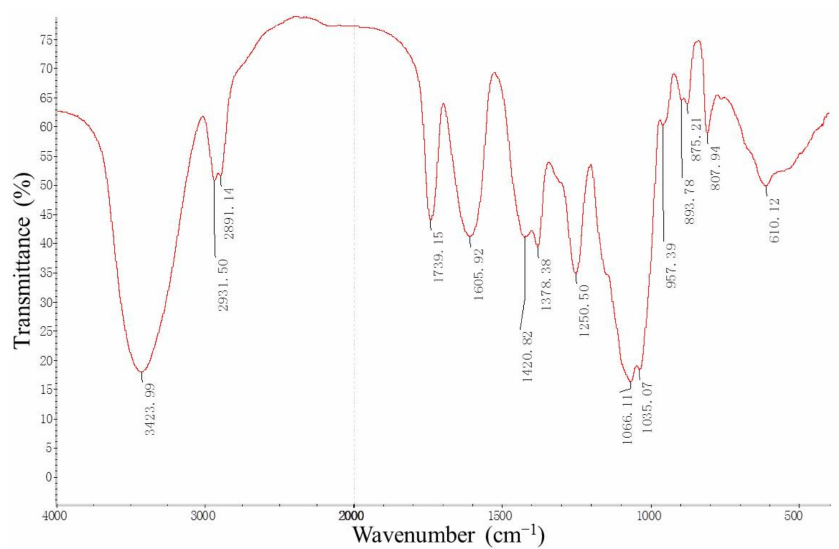
Figure 6. The FT-IR spectrum of the processed